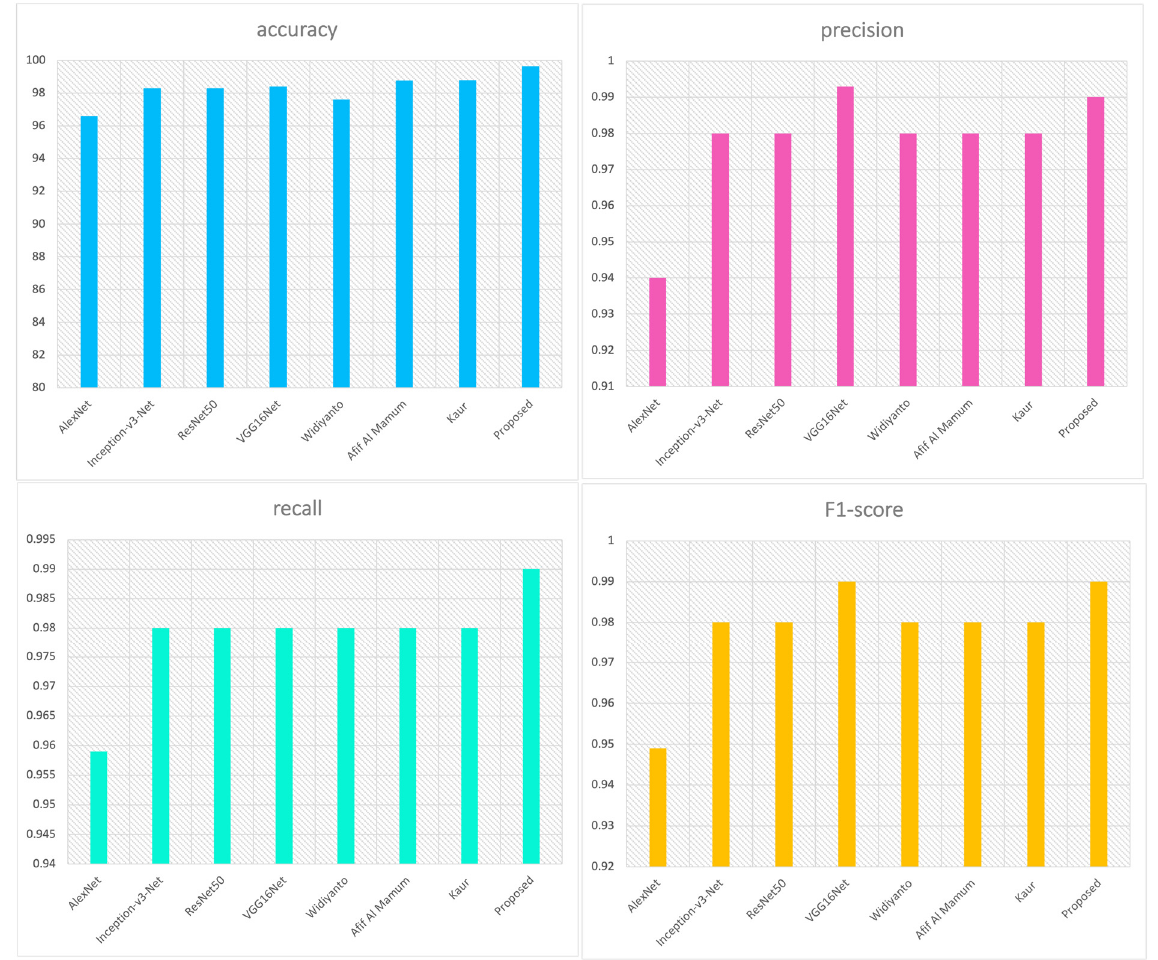
Figure 8. Performance comparison of proposed model and existing models.